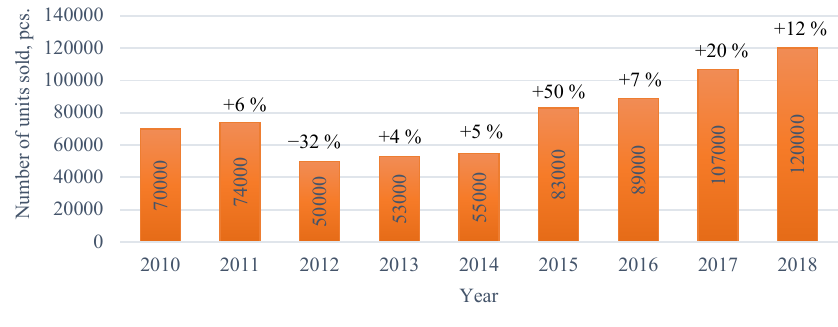
Fig. 7. The development of heat pump sales in